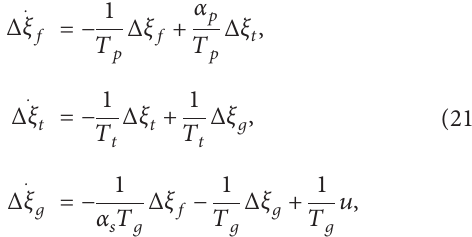
Figure 6. Figure 6(a) implies the system states cannot be stabilized without control. Then, we apply the optimal control strategy into the system. Figure 6(b) indicates the system states can be stabilized after 8 time steps under optimal control. Comparing the trajectories of the system states, the superior control performance of optimal control strategy can be observed. Figure 6(c) shows the 2D plot of convergence trajectory in detail. Figure 6(d) provides the evolution of the control input. The aforementioned simu- lation results demonstrate the high stability, fast conver- gence, and low control cost of the DT optimal control